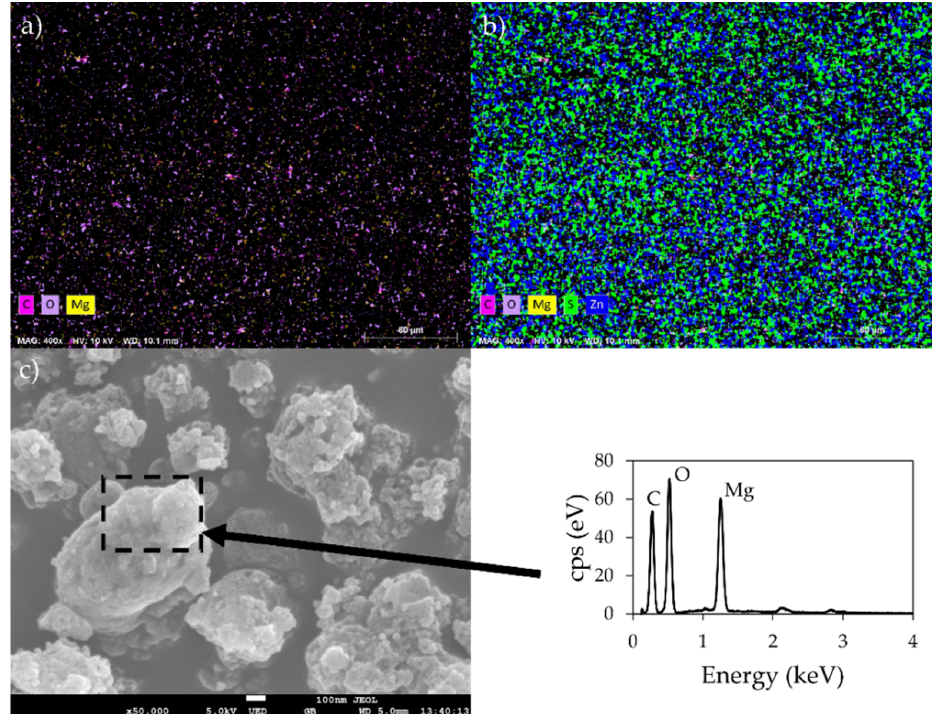
Figure 7. Mapping of location elements for the surface of Cu-activated sphalerite conditioned with SIPX in presence of Mg + Na 2 CO 3 and the morphology and composition of the dispersed Mg species: ( a ) C, O, and Mg, ( b ) C, O, Mg, S, and Zn, and ( c ) morphology and EDSX microprobe